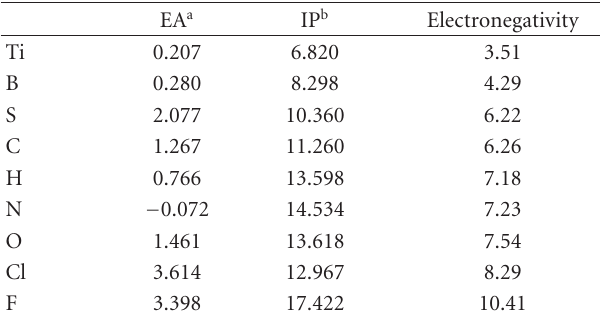
Table 1: EA, IP, and calculated electronegativity for several species. Unit is